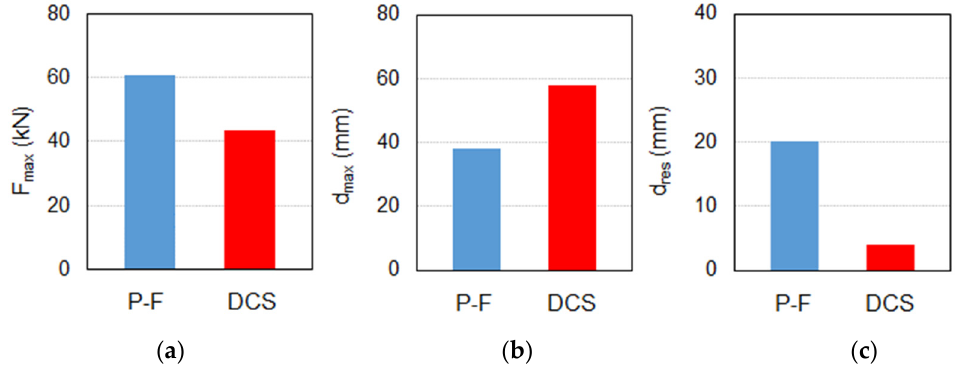
Figure 15. Comparison of the seismic response (averaged on seven ground motions) of DCS and pure friction (P-F) joint: ( a ) maximum force; ( b ) maximum displacement; ( c ) residual